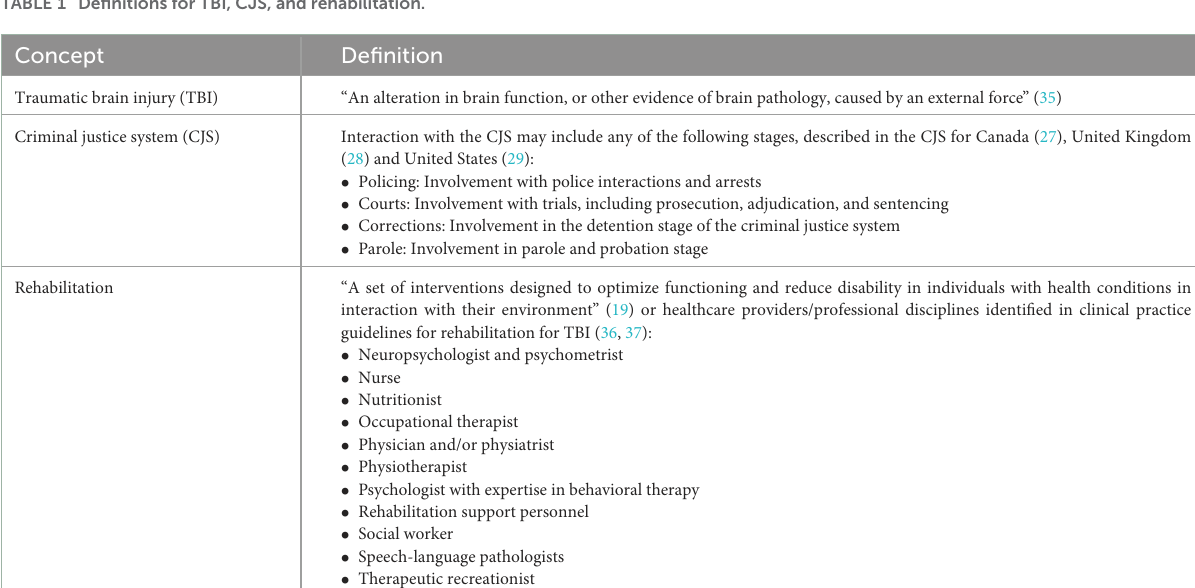
TABLE 1 Definitions for TBI, CJS, and